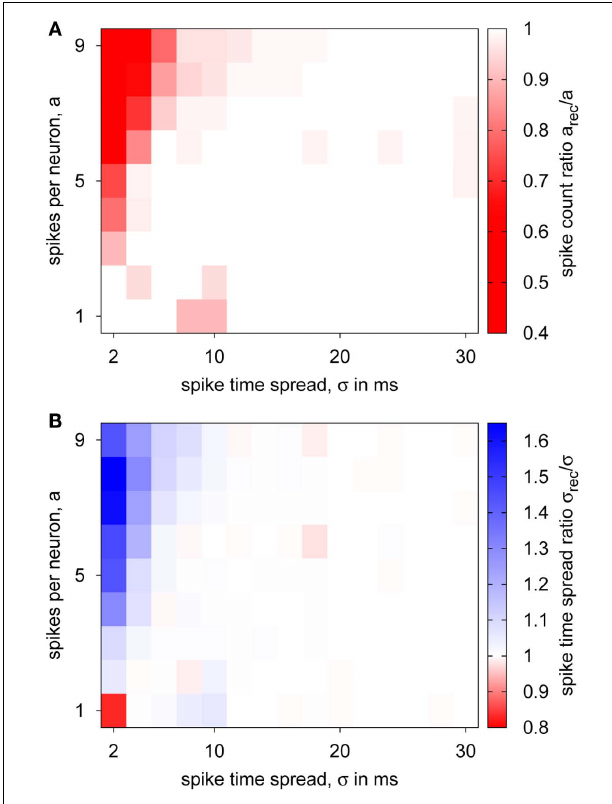
FIGURE 12 |Transmission of spike volleys by the PCS. Pulse packets for 10 spike sources with varying number of spikes per neuron a and temporal spread σ were transmitted via the PCS, configured with an 8-ms delay, and the received spike train characterized: (A) fraction of actually transmitted pulses, (B) temporal spread ratio of received and sent pulse